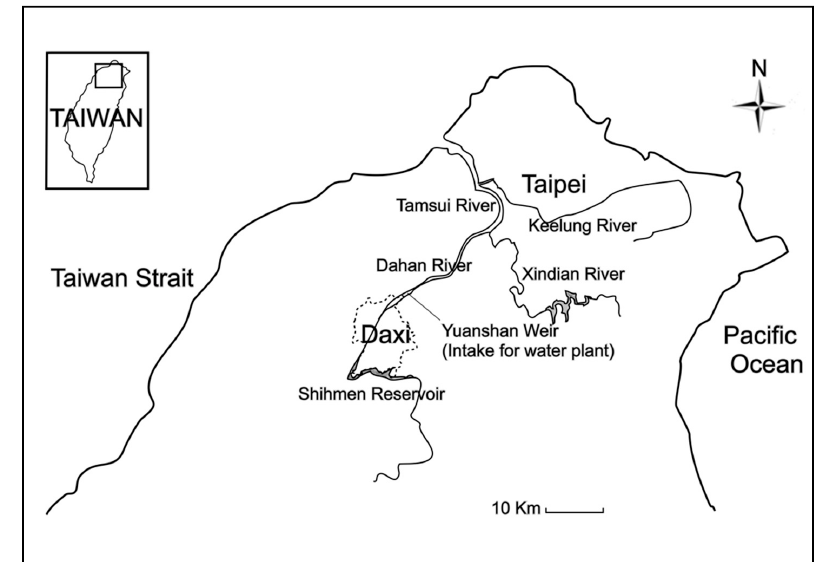
Figure 1. The map of Daxi and the Dahan River.